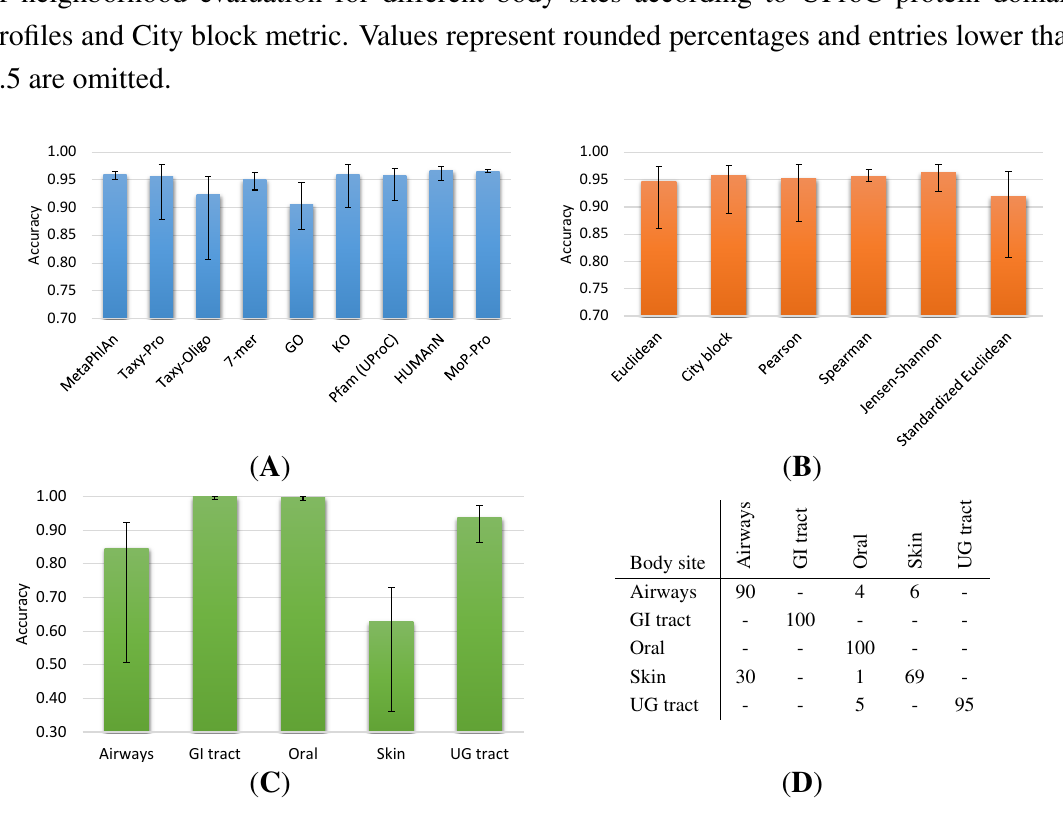
Figure 1. Neighborhood accuracy on Human Microbiome Project (HMP) data for different profiling methods, metrics and body